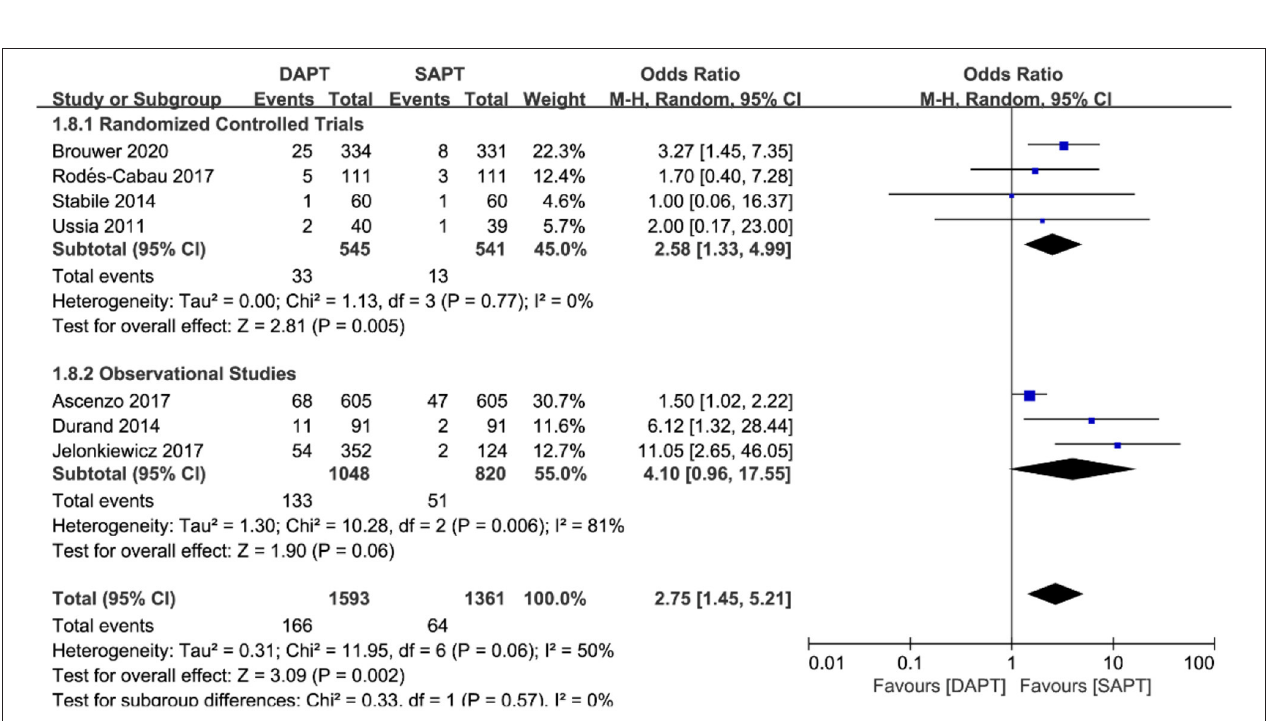
FIGURE 9 | Forest plot for major bleeding with subgroup analysis stratified by study type at longest follow-up.